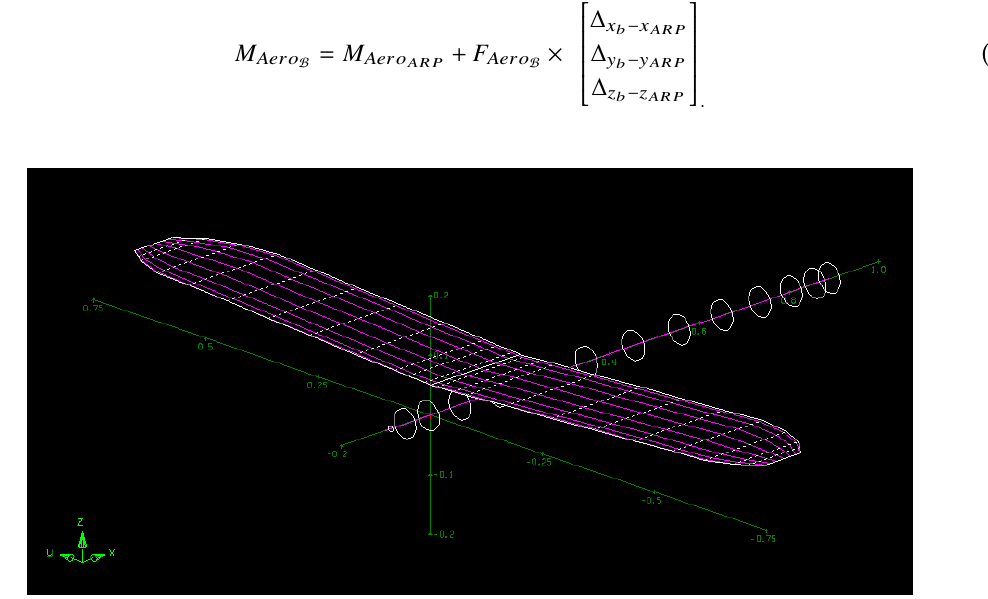
Figure 7. Aircraft model in